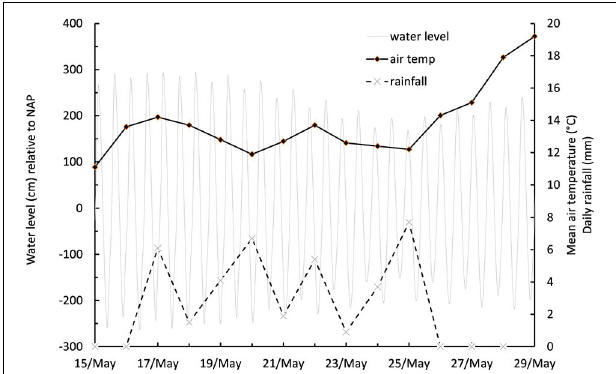
FIGURE 3 | Meteorological and tidal conditions during the measurement period from May 15 to May